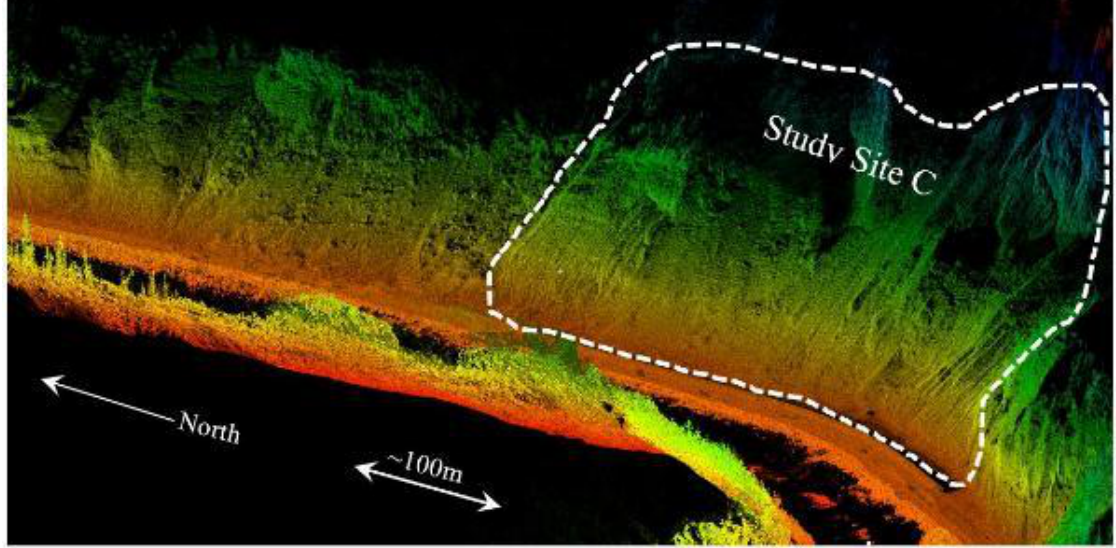
Figure 3. Perspective view of a sample point cloud for a 1 km section of the Parks Highway obtained with combined TLS and MLS data . The dashed line highlights Study Site